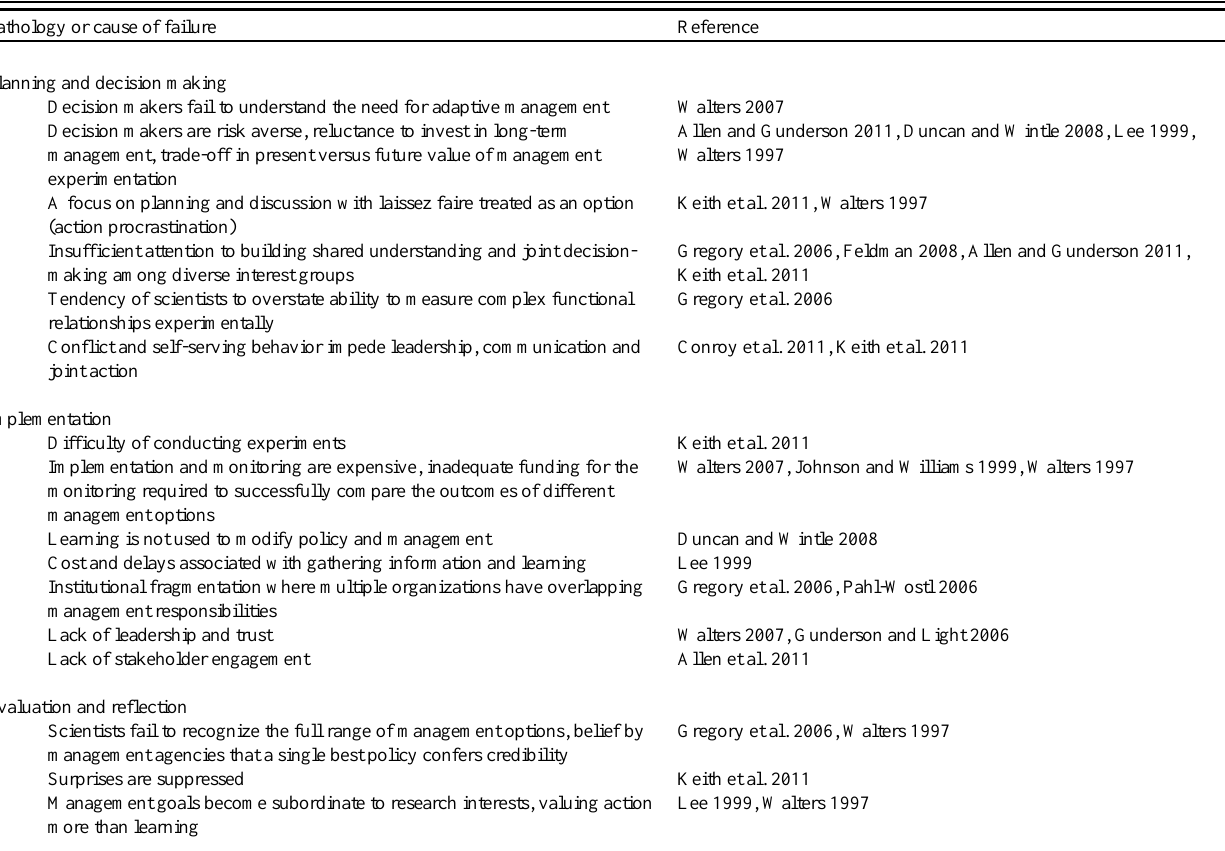
Table 2 . Identified ‘pathologies’ and reasons for failure Pathology or cause of failure